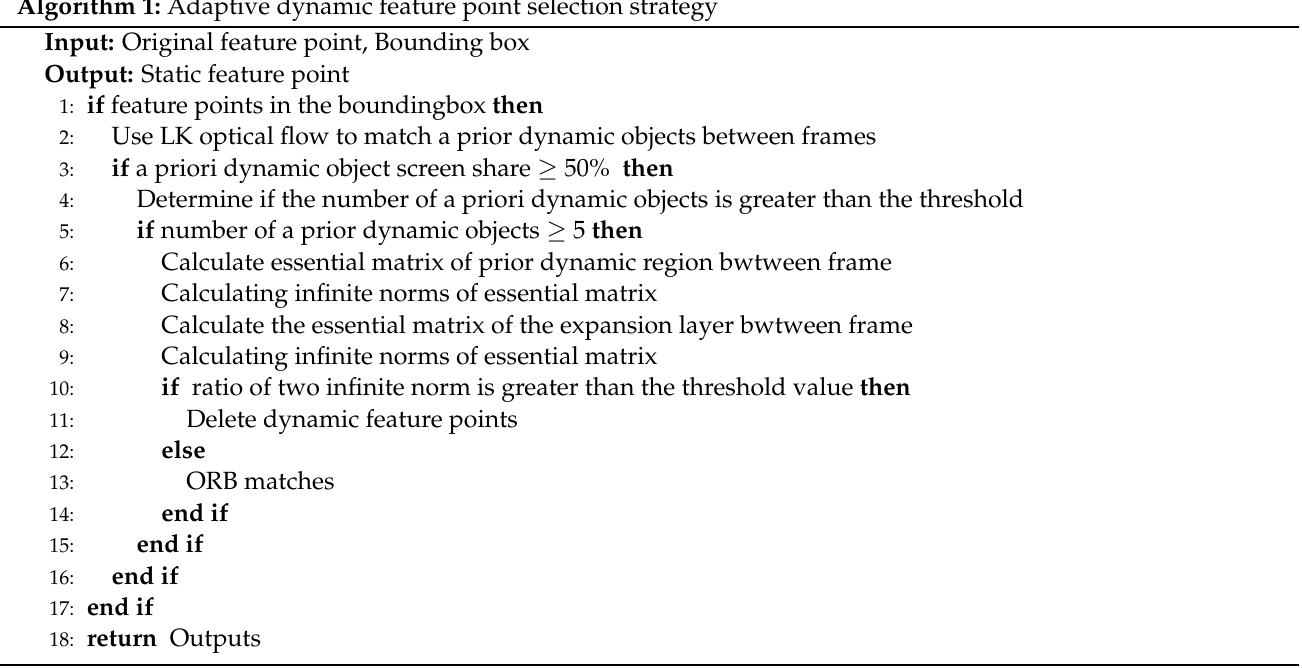
Algorithm 1: Adaptive dynamic feature point selection